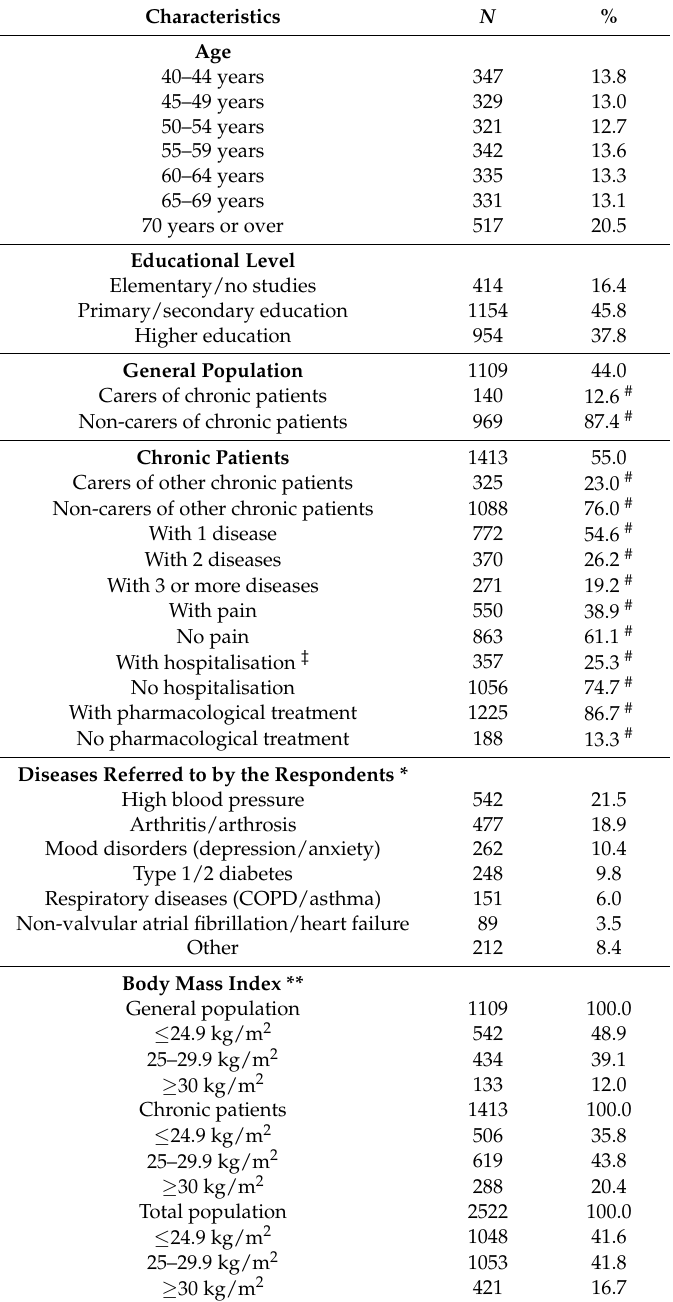
Table 1. Characteristics of the respondents ( n =